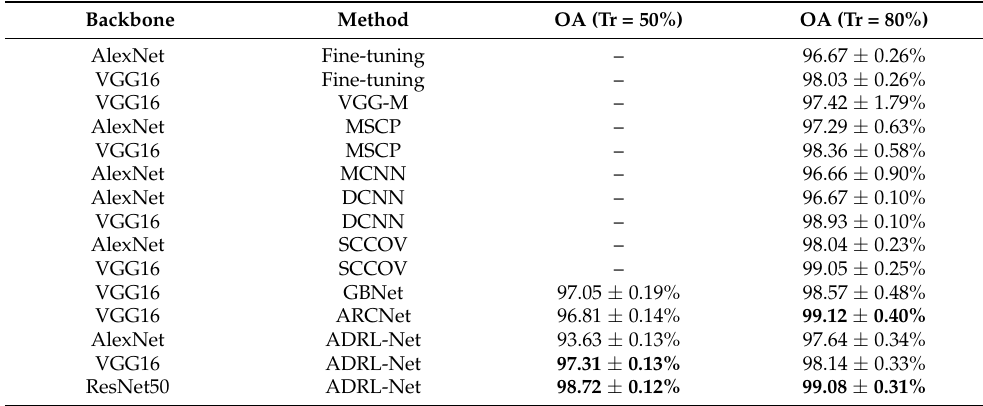
Figure 5. Confusion matrices obtained by ADRL-Net with ResNet50 as backbone on AID dataset. Tr = 50%. Table 2. OA comparison of different methods on UC Merced dataset. The best two results are highlighted in bold